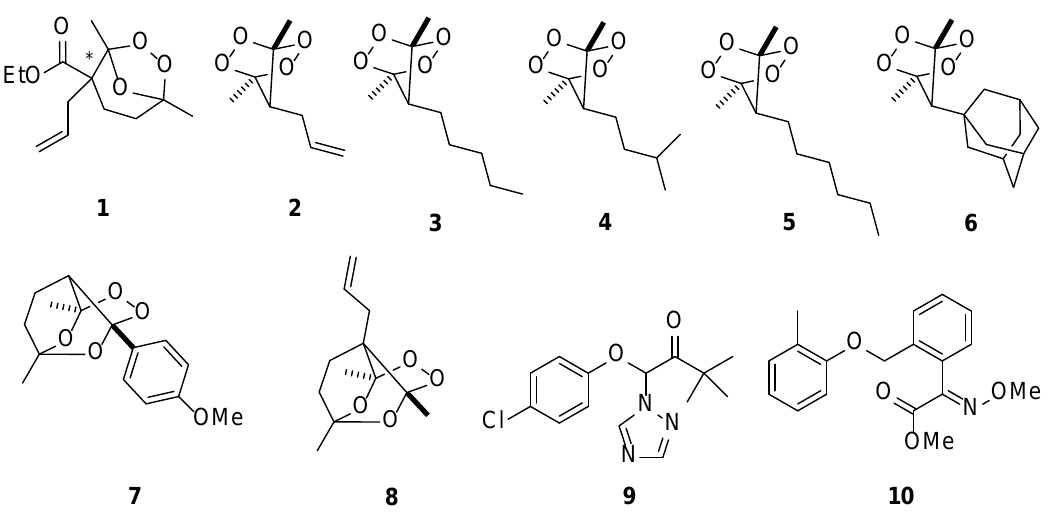
Figure 2. Structures of investigated peroxides 1 – 8 and the commercial fungicides Triadimefon 9 and Kresoxim-methyl 10 .